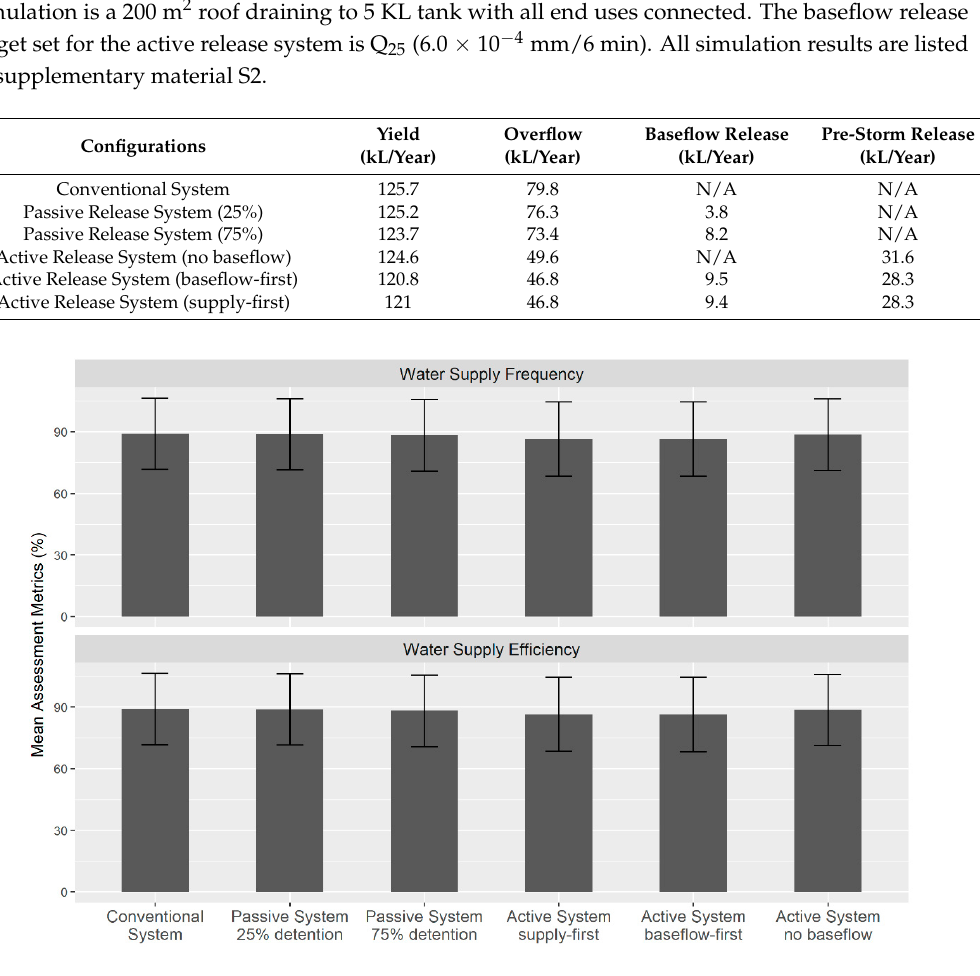
Figure 3. Mean value (bar) and associated standard deviation (error bar) for water supply efficiency and frequency in the six system configurations. Water supply efficiency and frequency are expressed as percentages.